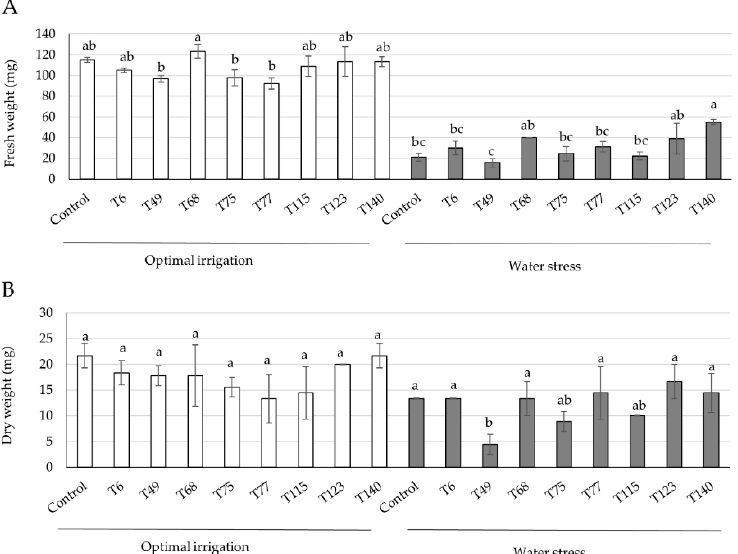
Figure 1. Fresh ( A ) and dry ( B ) weights of the aerial parts of 4-week-old wheat seedlings derived from Trichoderma (T6-T140)-treated and -untreated (control) seeds grown under optimal irrigation and water stress (irrigation withdrawn during the third and fourth weeks) conditions. The values are the means of three biological replicates per treatment and condition ( n = 3), and the corresponding standard deviations. For each condition, different letters above the bars indicate significant differences according to one-way analysis of variance (ANOVA) followed by Tukey’s test ( p < 0.05).